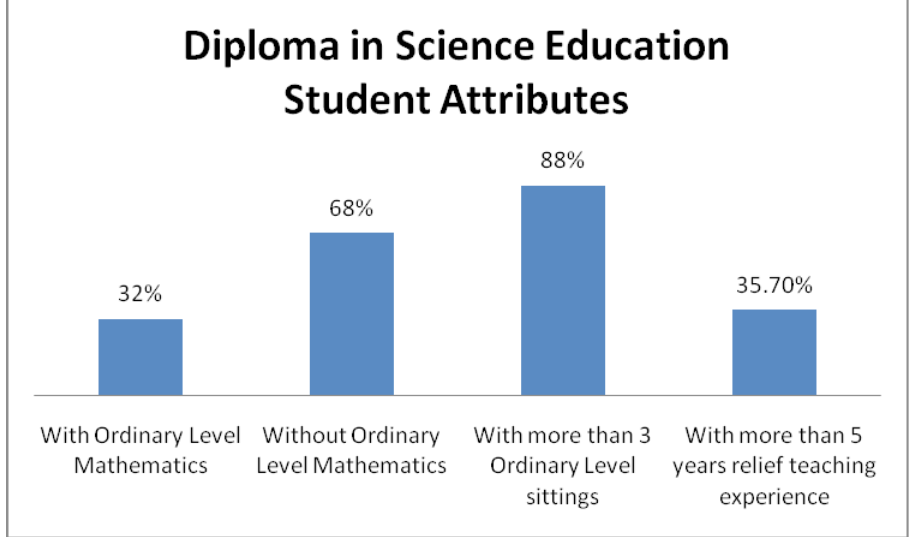
Figure 4. Showing Diploma in Science Education students’